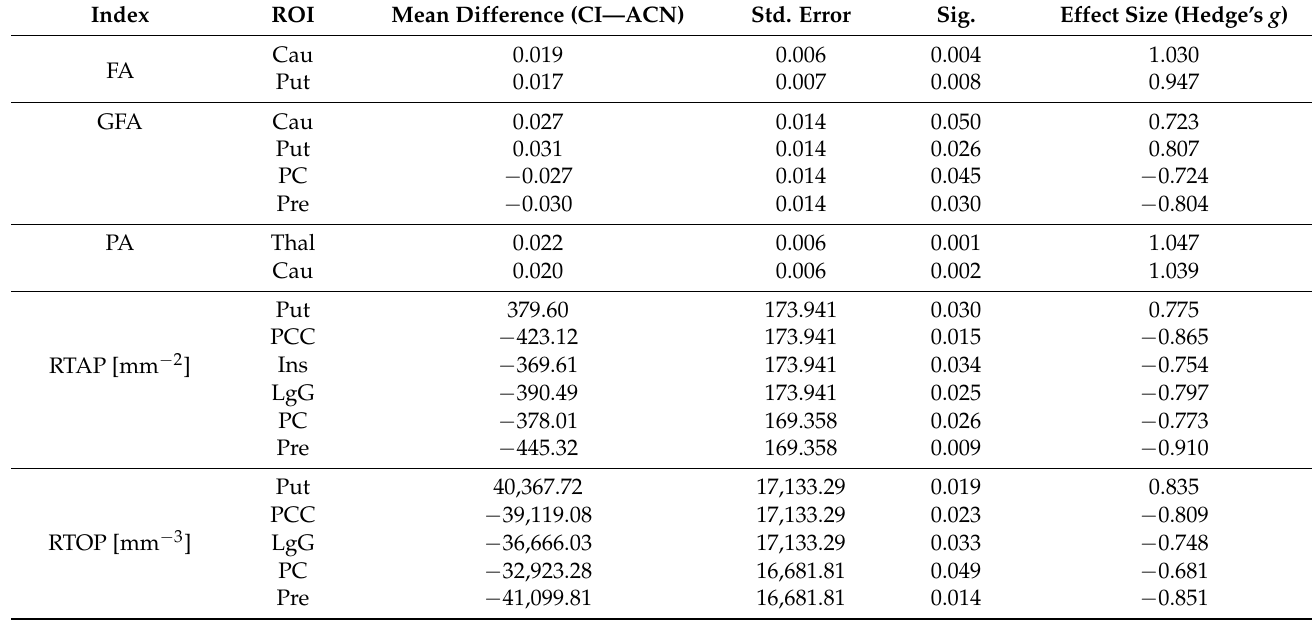
Hedge’s g factors were calculated using the pooled standard deviation plus a bias correction for small sample